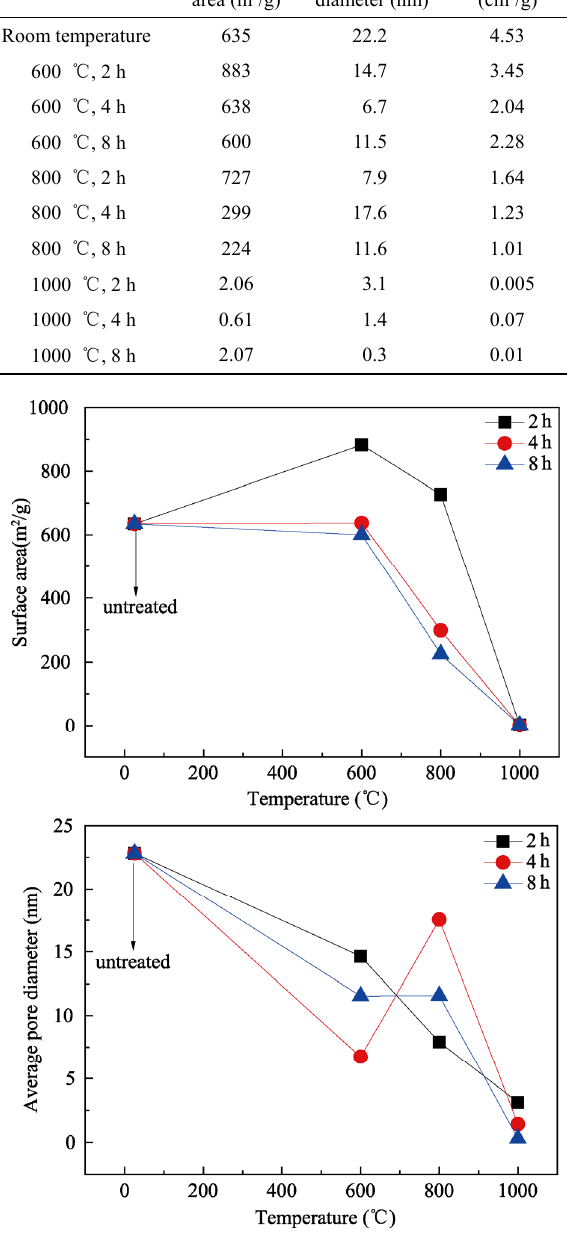
Fig. 4 XRD patterns of SiO 2 aerogels calcined at different temperatures.